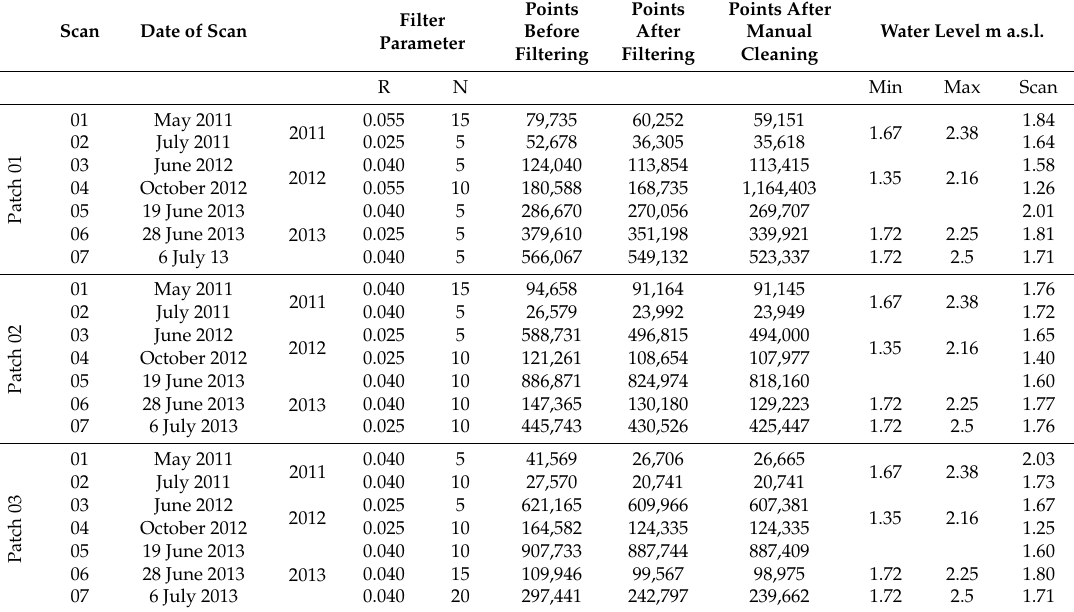
Table 2. Results of filtering of terrestrial laser scanning (TLS) point